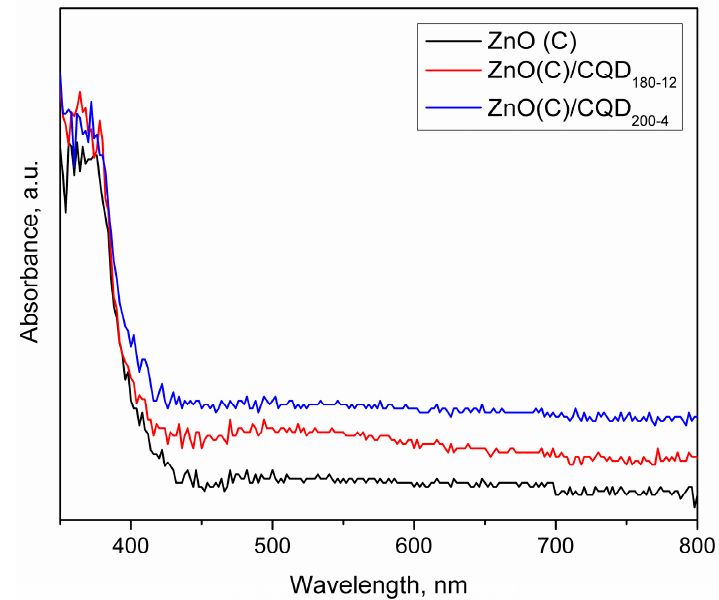
Figure 10. UV-Vis diffuse reflectance spectra of ZnO(C)/CQDs samples.